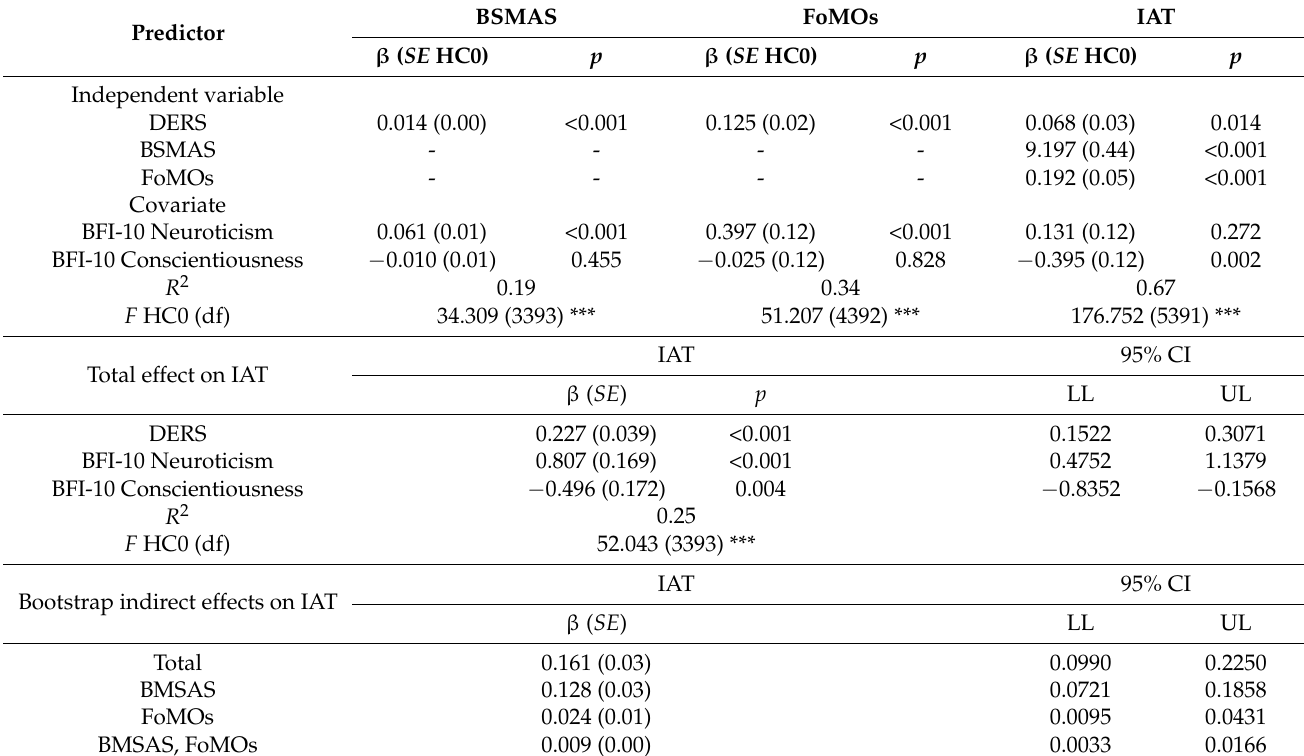
Table 3. Model coefficients for the serial mediation analysis ( n =